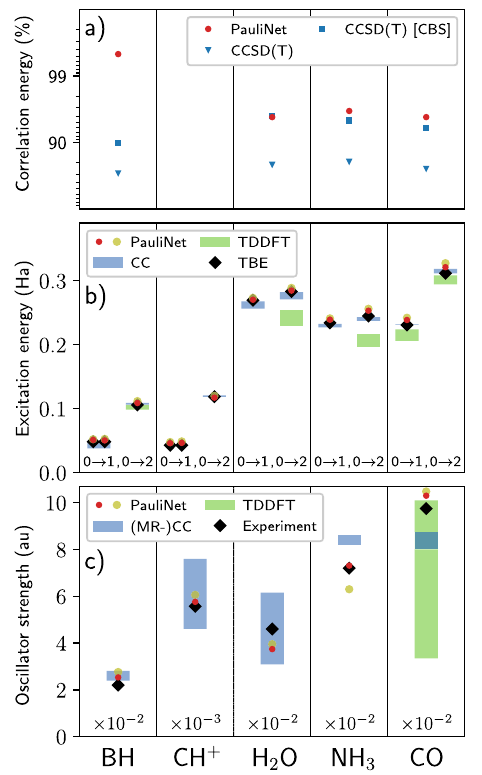
Fig. 3 | Deep VMC obtains highly accurate excited-state energies and wave- functions for small molecules. a PauliNet recovers the same amount of correla- tion energy as high-order CC methods 36 . (CH + : No better reference energy to compare with.) b Lowest triplet (0 → 1) and singlet (0 → 2) excitation energies obtained using PauliNet (with (red) and without (yellow) variance matching), CC, and TDDFT, with the TBE given. (BH and CH + exhibit degeneracy for the triplet state; CCisCCSD or higher, exceptfor the triplet state of BHwhichincludes CC2.) c Oscillatorstrengthscomputedforthe0 → 2transitions.PauliNetcompareswellto experiment in all systems and matches the accuracy of (MR − )CC results, demon-